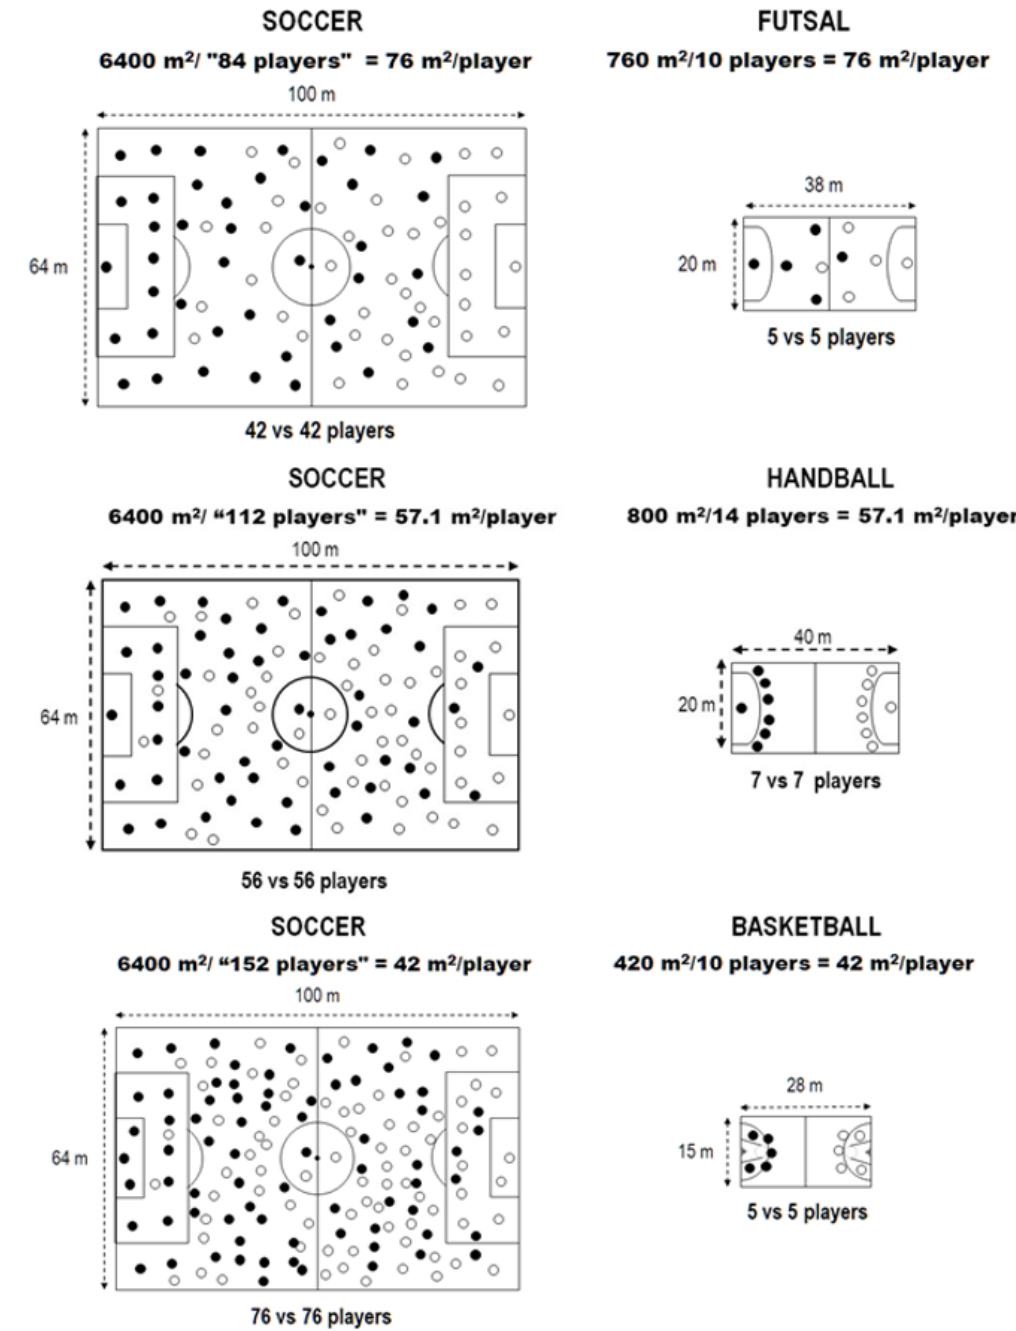
Figure 2. Simulations to equate soccer (i.e., to have similar m 2 / player) to other team sports’ relative dimensions, by increasing the number of soccer players.